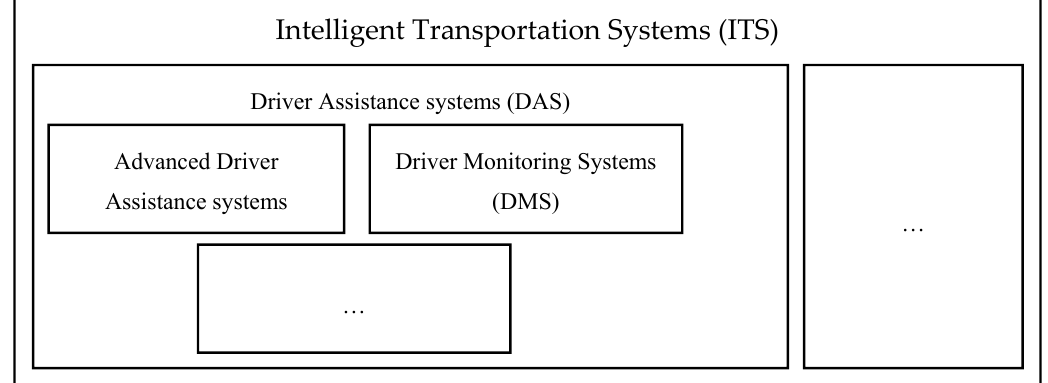
Figure 1. ITS Classification for vulnerability detection in vehicle cabin.